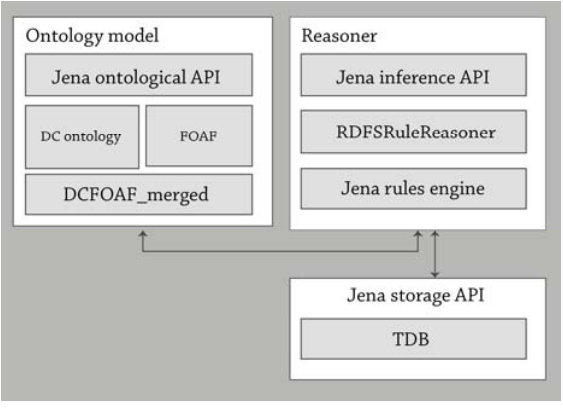
Figure 10. Architecture of the OntoOAI inference engine.